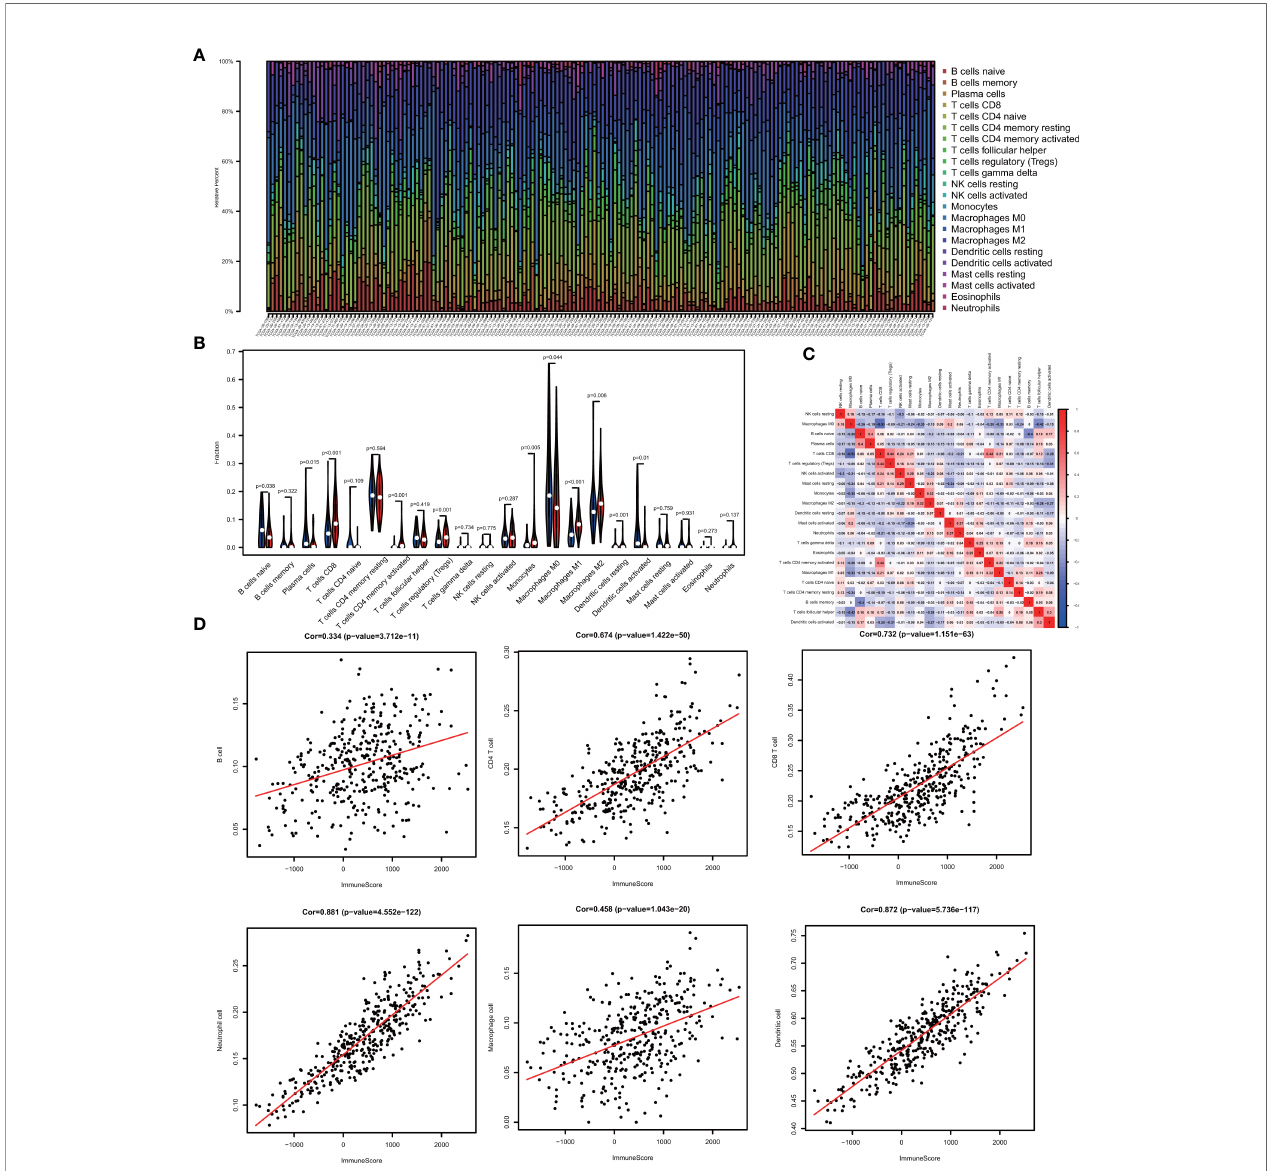
FIGURE 1 | The landscape of immune in fi ltration in low and high immune score OV patients. (A) Relative fractions of immune cells in high and low immune score groups. (B) The proportion of different types of immune cells in high and low immune score groups. High immune score groups contains a higher proportion of T cells CD(P value=0.000), T cells CD4 memory activated (P value=0.000), T cells regulatory (Tregs) (P value=0.001), Monocytes (P value=0.005), Macrophages M1 (P value=0.000), Macrophages M2 (P value=0.006) and Dendritic cells resting (P value=0.001), while B cells naïve (P value=0.038), Plasma cells (P value=0.015), Macrophages M0 (P value=0.044) and Dendritic cells activated (P value=0.001) were lower. (C) Correlation matrix of all 22 immune cell proportions. (D) Correlations between immune score and immune in fi ltrating level of 6 types of immune